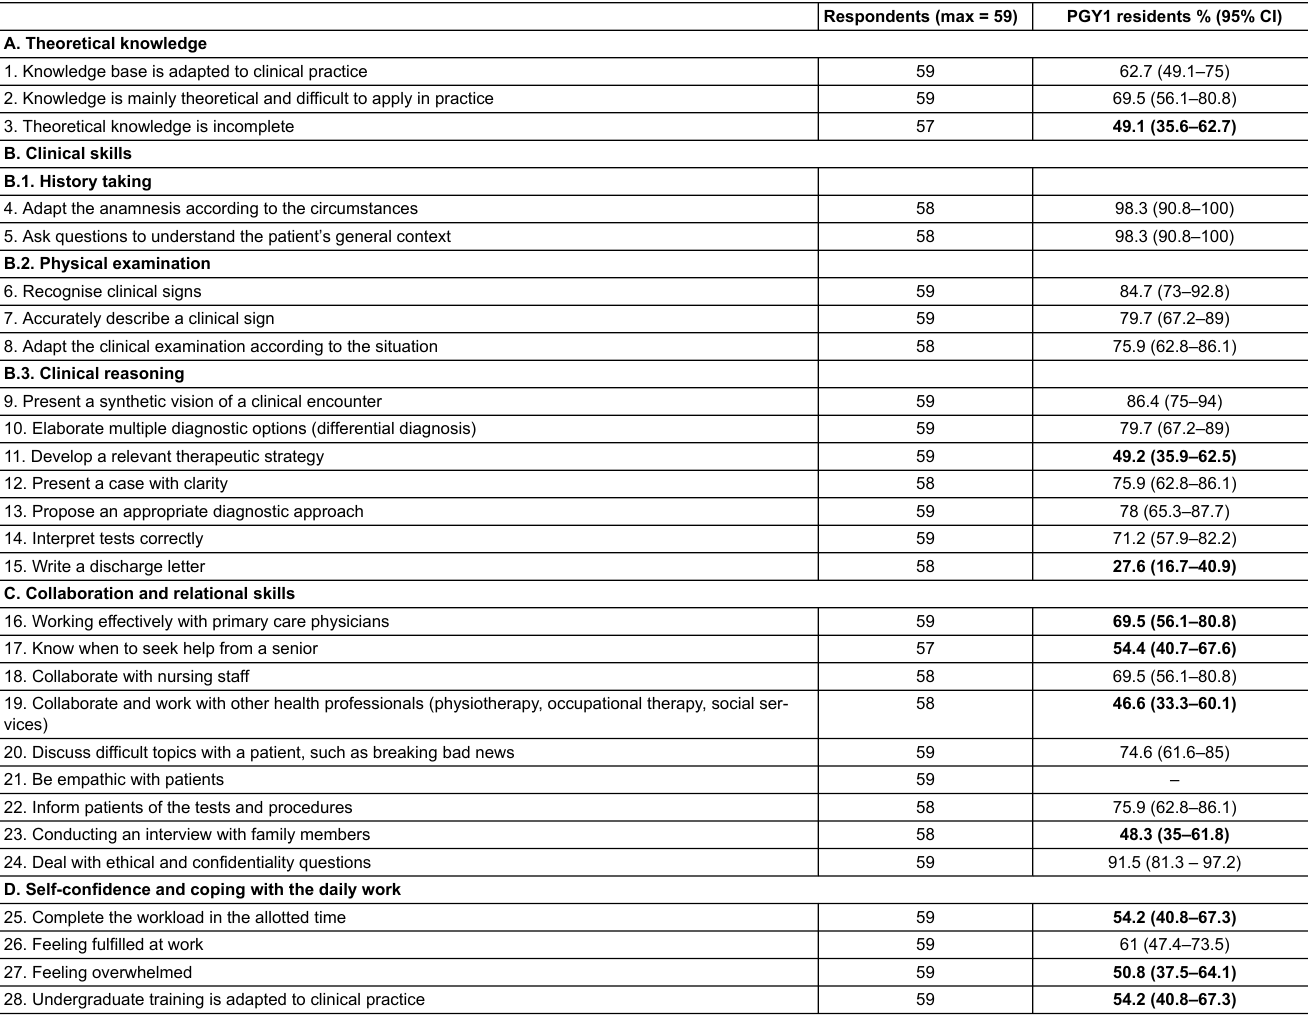
Table 2: First-year postgraduate (PGY1) residents’ assessment of their competences as “well or rather well